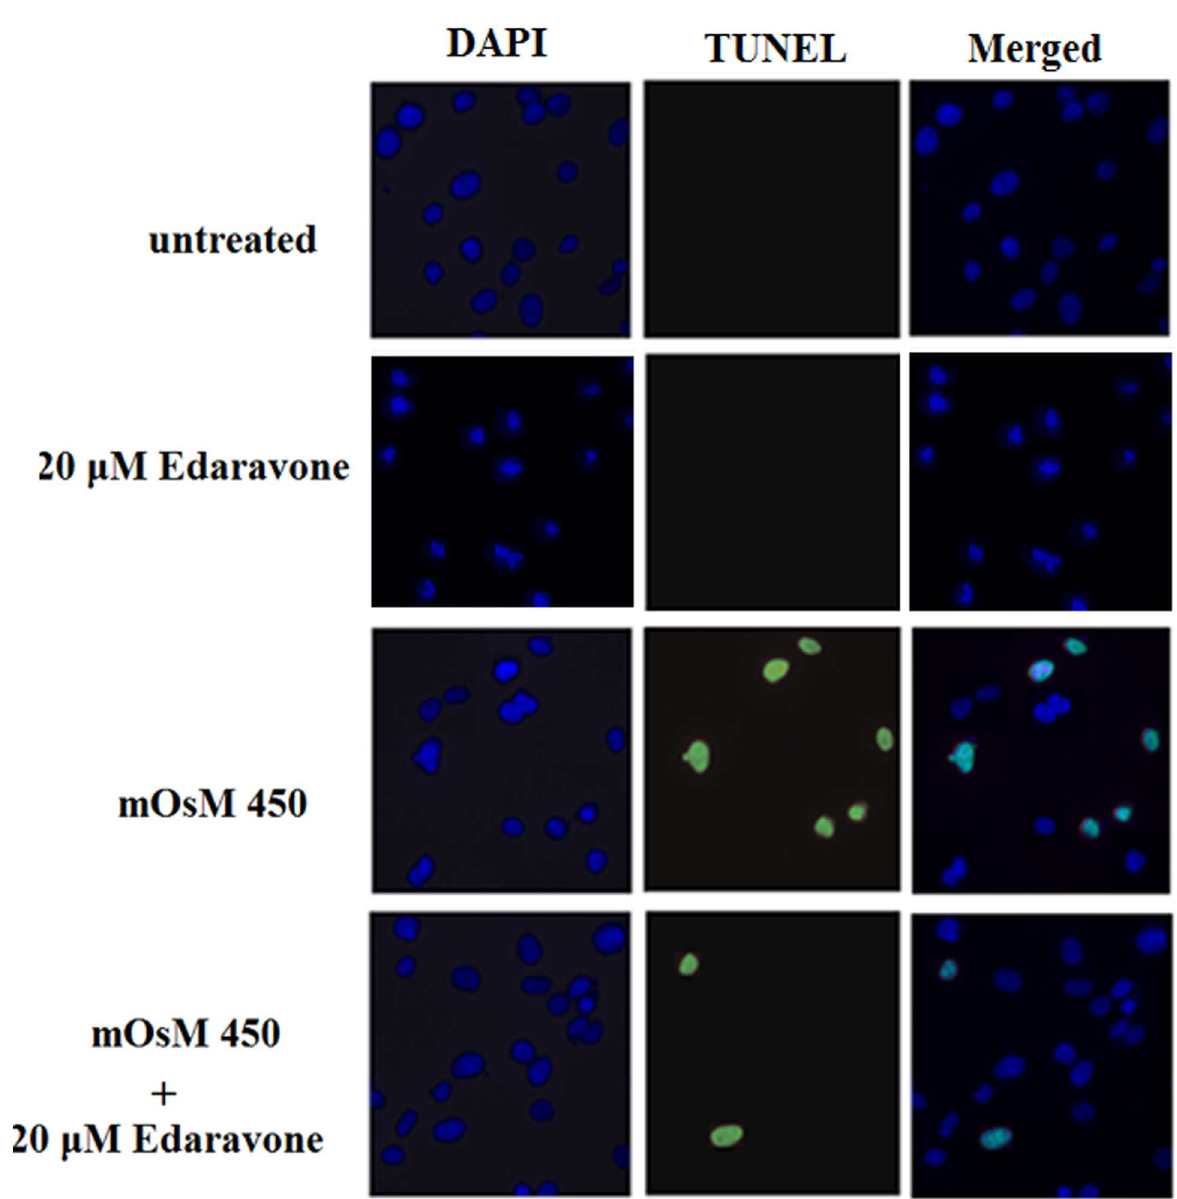
Fig 5. Effects of edaravone on apoptosis in primary HCEpiCs exposed to hyperosmotic media (400–450mOsM). Apoptotic cells were stainedusing a TUNEL Assay Kit. NuclearDNA was stained with DAPI.